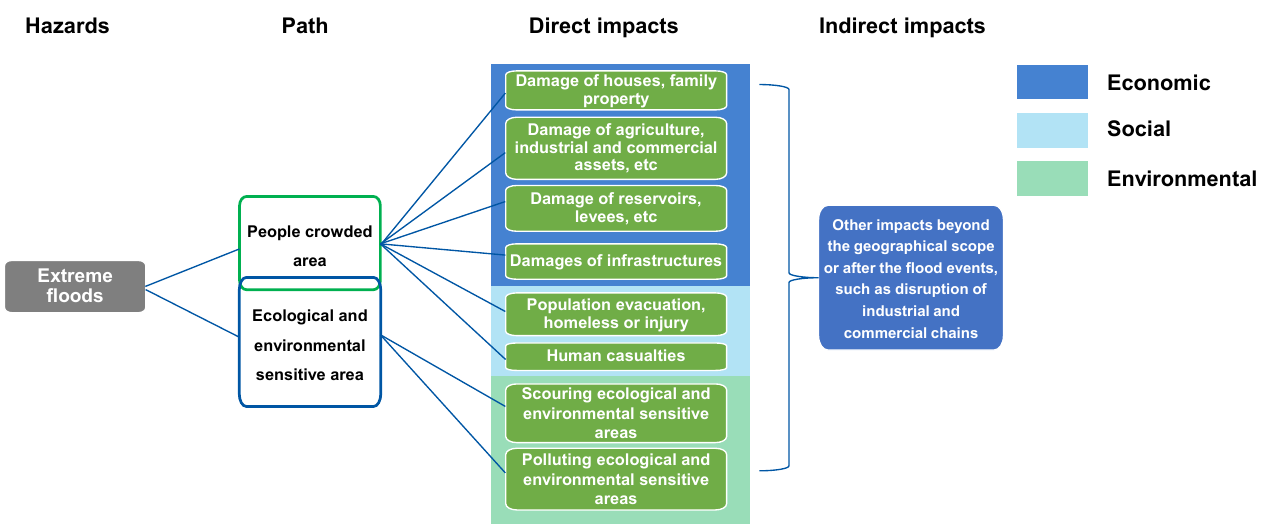
Figure 2. Extreme flood disaster chains (direct and indirect impact refer to the consequences occurring within the inundated region and far away from the flooded region during and/or after a flooding event,